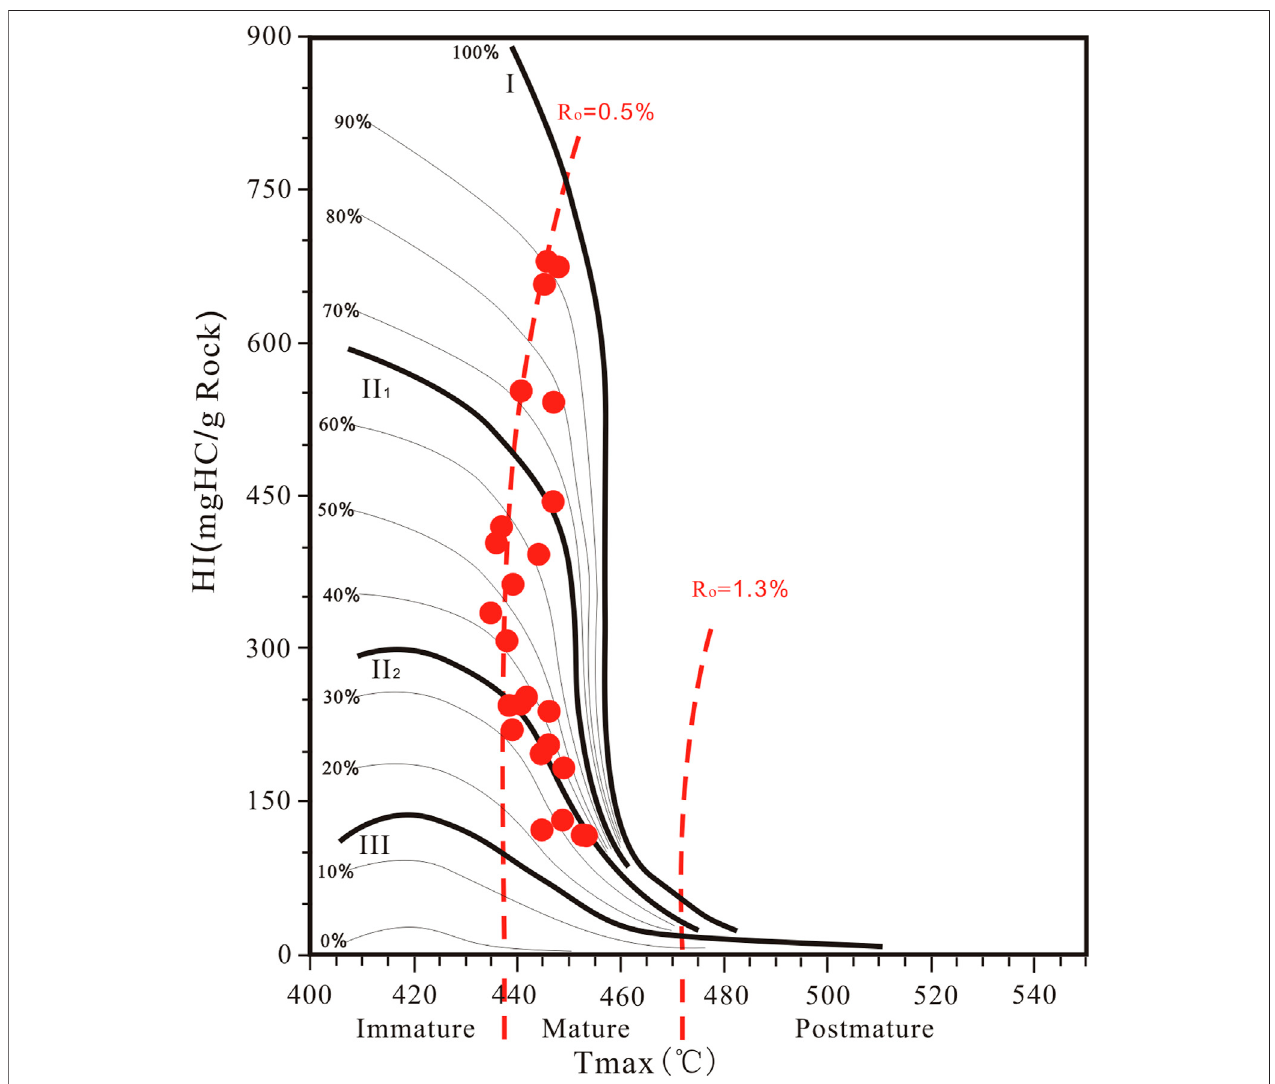
FIGURE 5 | Cross plot of hydrogen Index and maximum pyrolysis temperature, which indicates that the Chang-7 shale is in a mature stage.